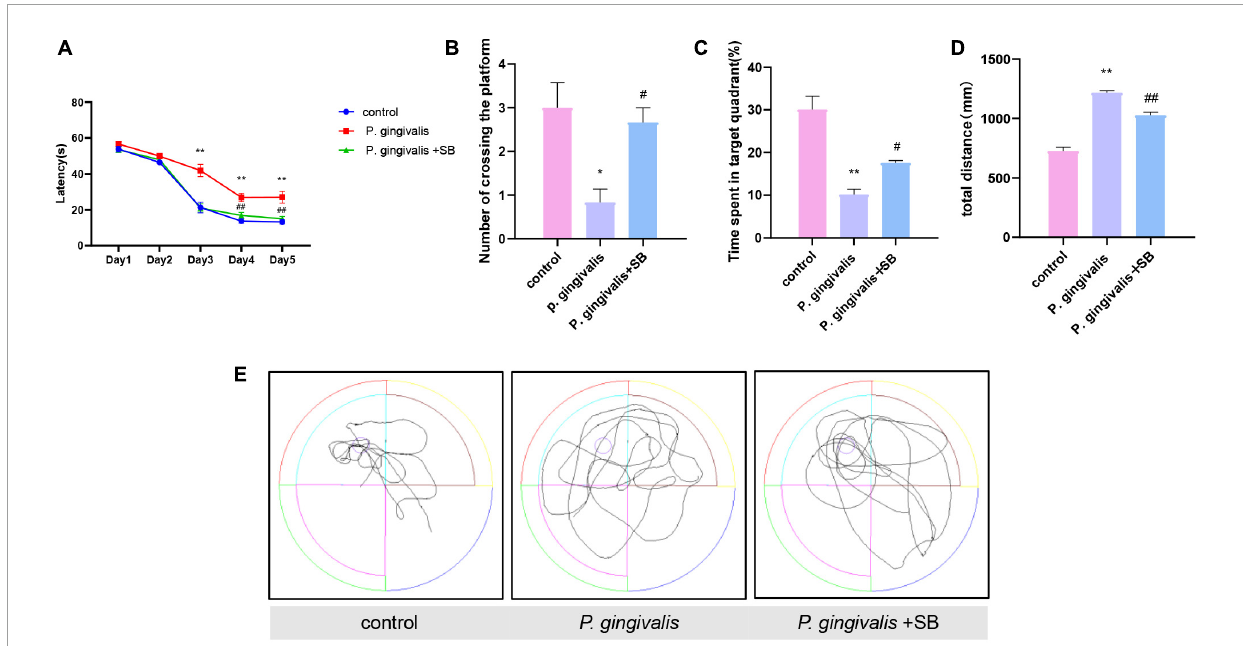
FIGURE3 Effects of periodontal inflammation on spatial learning and memory in the MWM test. (A) Latency in finding the platform during the acquisition phase of the MWM test. (B) Number of platform crossings in the target quadrant. (C) Percentage of time spent in the target quadrant. (D) The total distance traveled by rats in the MWM test. (E) The typical trajectory. The platform is represented by a circle. Experimental values are expressed as the mean ± SEM ( n = 8 per group). * p < 0.05 and ** p < 0.01 compared with the control group, # p < 0.05 and ## p < 0.01 compared with the P. gingivalis group.